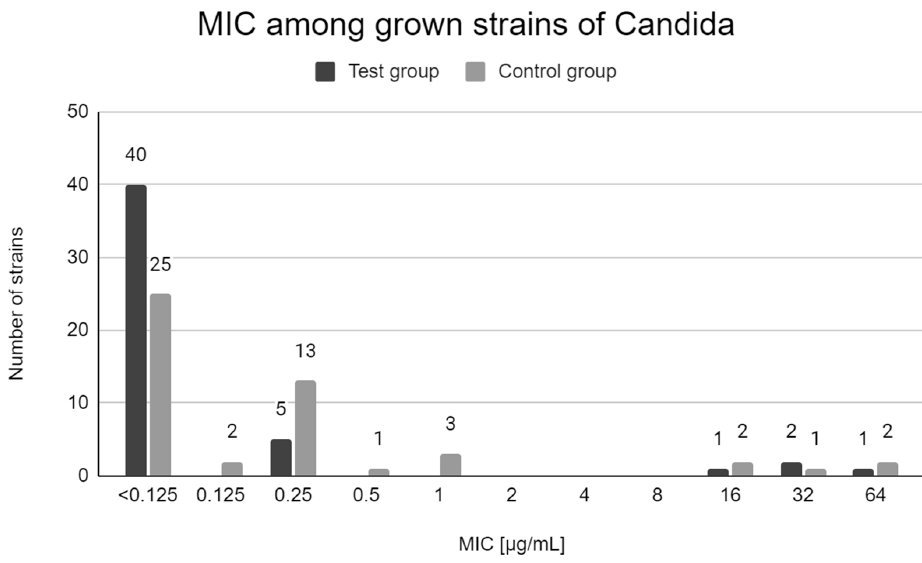
Figure 1. Distribution of MICs of fluconazole among Candida strains in test group patients and control group patients.